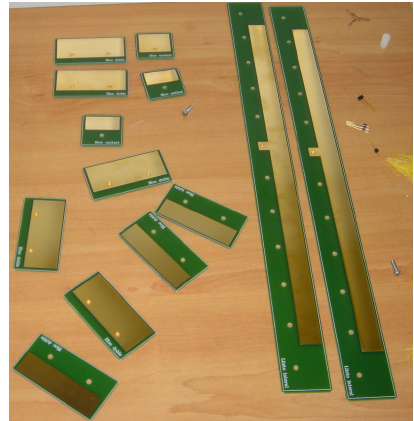
Figure 2. Photograph of the test bank